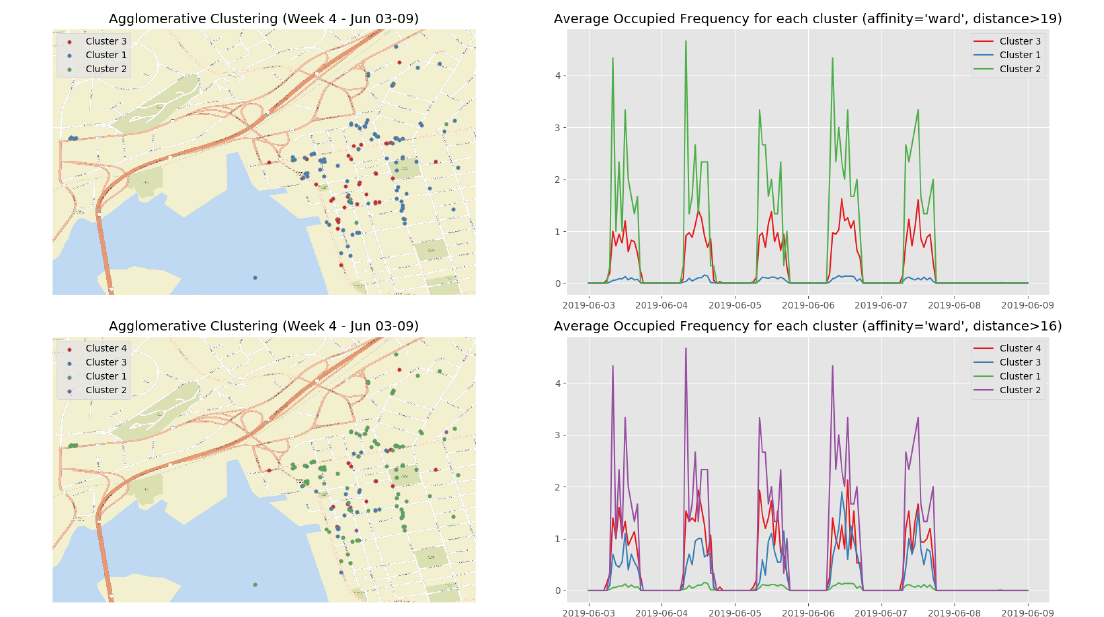
Figure A5. Clustering results for the 4th